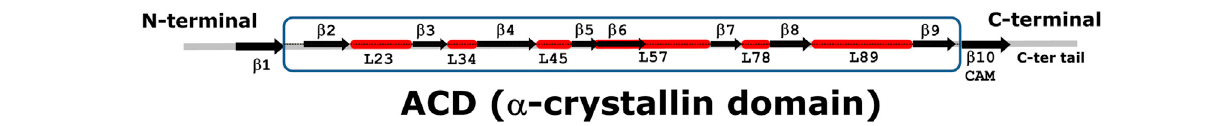
FIGURE 3 | Representation of the structural topology of monomeric sHsps. ACD is the region delimited from the β 2-strand to the β 9-strand. The β 1-strand is localized in the N-terminalregion. The β 10-strand corresponds to a conserved motif in the C-terminalregion. The fragment starting after the ACD and including the β 10- strandhasbeennamedtheC-terminalanchoringmodule(CAM).ResiduesthatfollowtheCAMwerede fi nedastheC-terminaltail.The β 6-strandandthe β 10-strandare not universally present in all sHsp (Poulain et al., 2010). The black arrows represent the β -strands and the red line, the link between two β -strands.